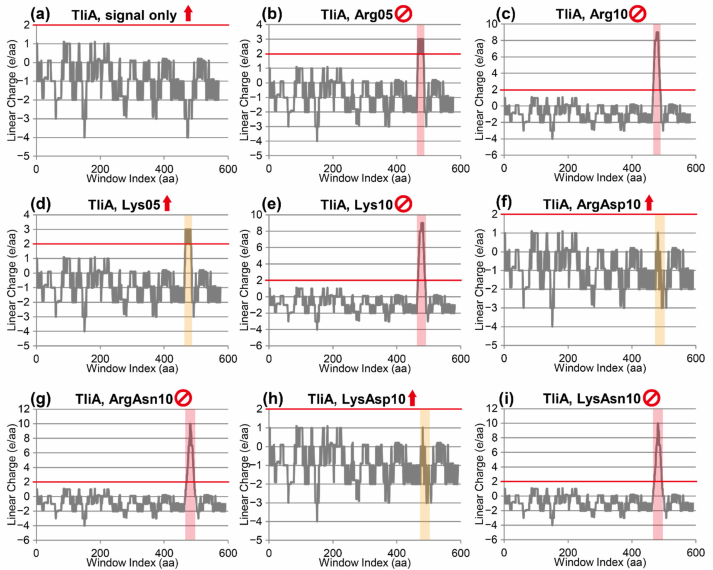
Figure A1. Linear charge density graphs of the artificial oligopeptide patch experiments, presented in Figures 3 and A2. A red arrow indicates that the protein was secreted, while a red